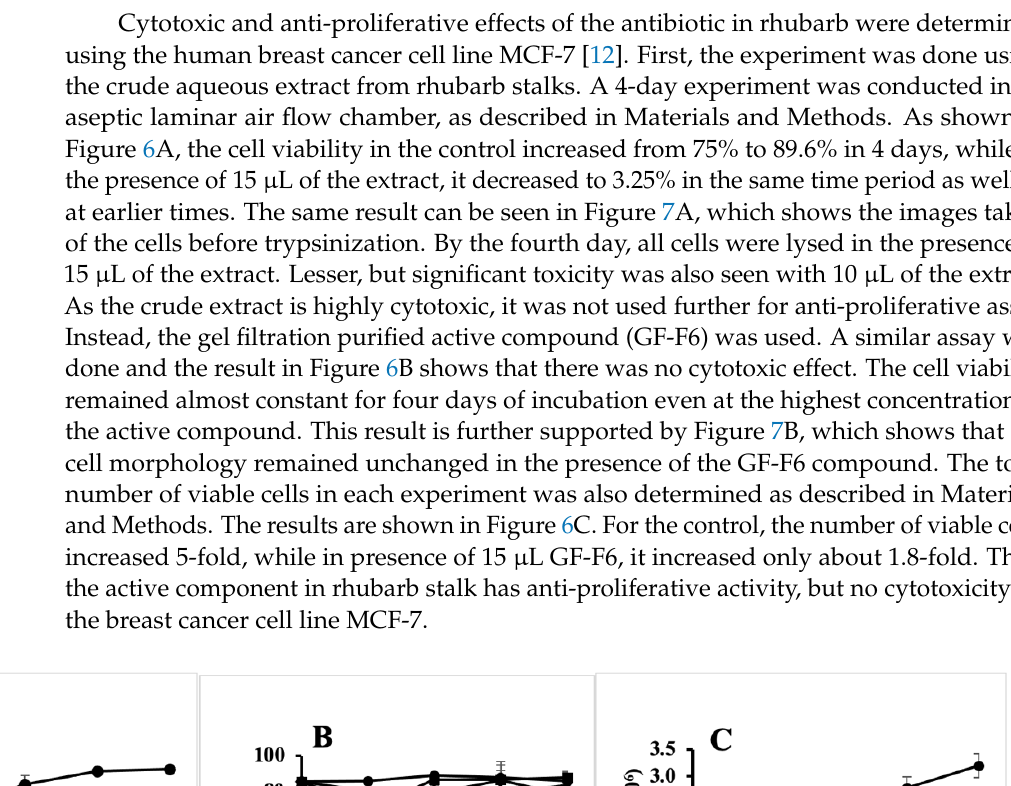
Figure 7. Disruption of cell structure by extract from rhubarb stalk. Images of MCF-7 cells were taken before trypsinization in the experiment described in Figure 6. ( A ) corresponds to cells in Figure 6A and ( B ) to cells in Figure 6B,C. 3. Discussion The term antibiotic was originally defined as natural products produced by microor- ganisms that can inhibit the growth of other microorganisms. However, with time, the original definition has now become obsolete for multiple reasons. Antibiotics do not nec- essarily have to be natural products. Numerous synthetic antibiotics have been shown to be very effective and have already saved millions of lives. In fact, the first commercially available antibiotics were the synthetic sulfa drugs [13]. Although the term antibiotics is generally used to describe drugs that inhibit bacteria, several antibiotics have been shown